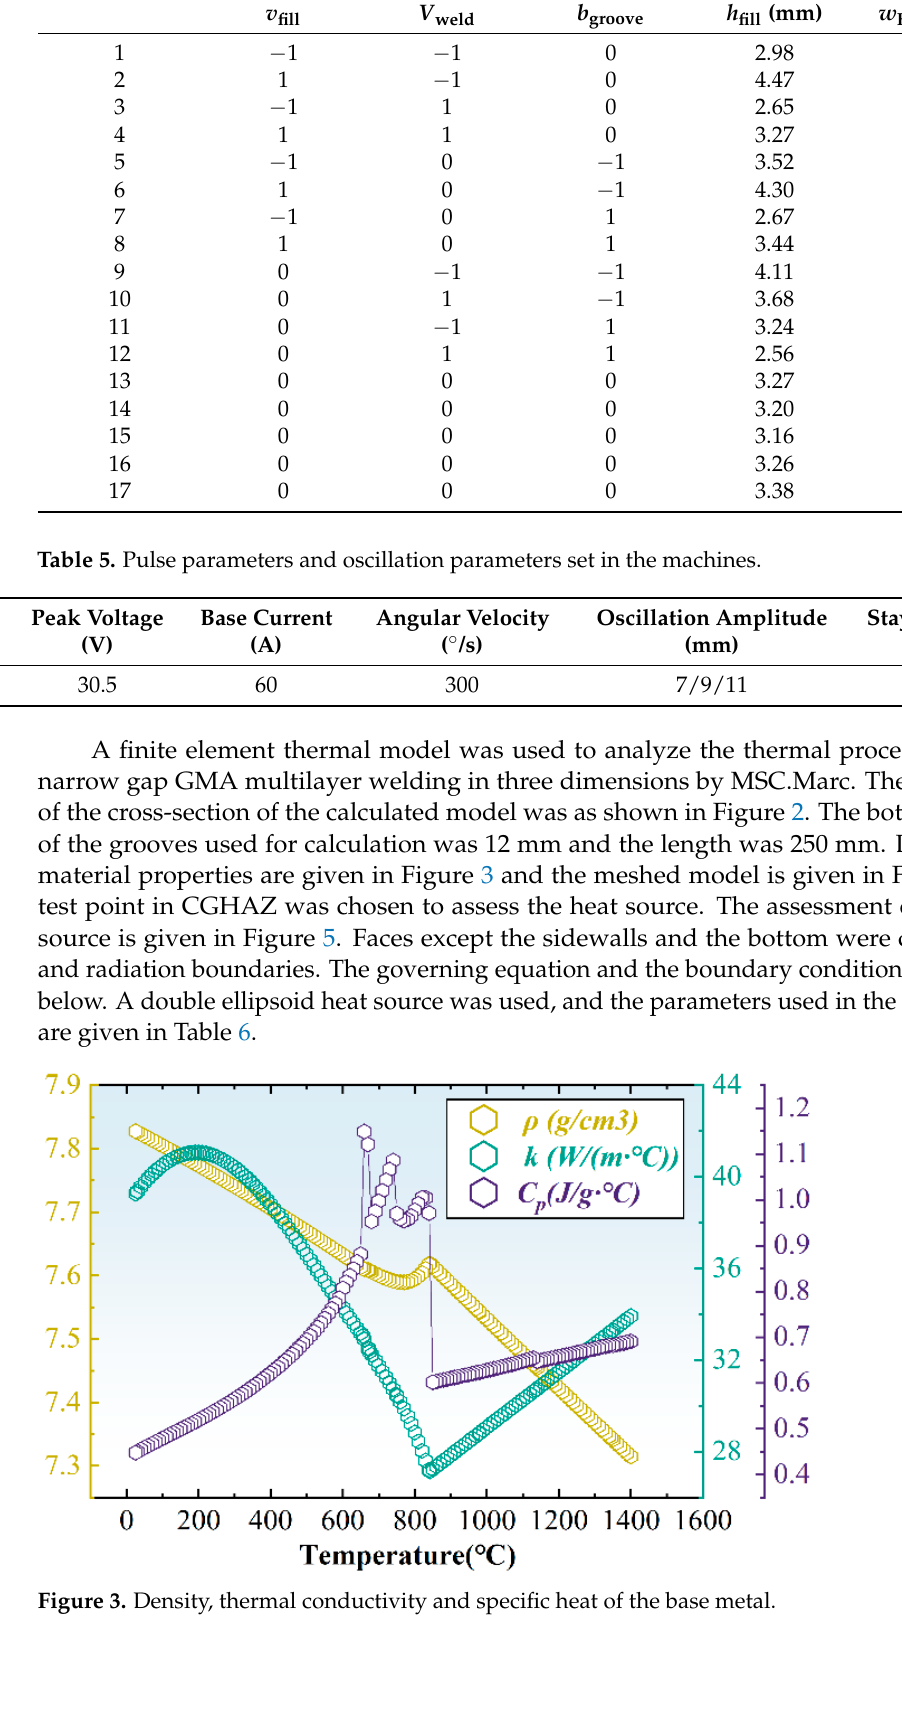
Figure 3. Density, thermal conductivity and specific heat of the base metal.